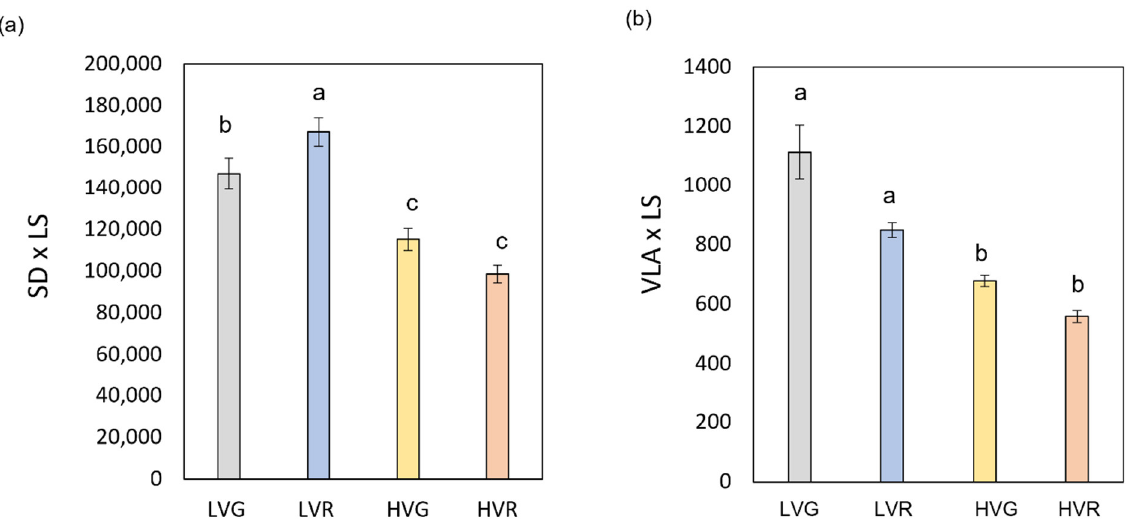
Figure 1. ( a ) Stomatal density per leaf size (SD × LS) and ( b ) vein density per leaf size (VLA × LS) of green and red Salanova lettuces grown under low and high VPD. Mean values ± standard errors are shown. Different letters correspond to statistically significant differences according to Tukey test ( p < 0.05).